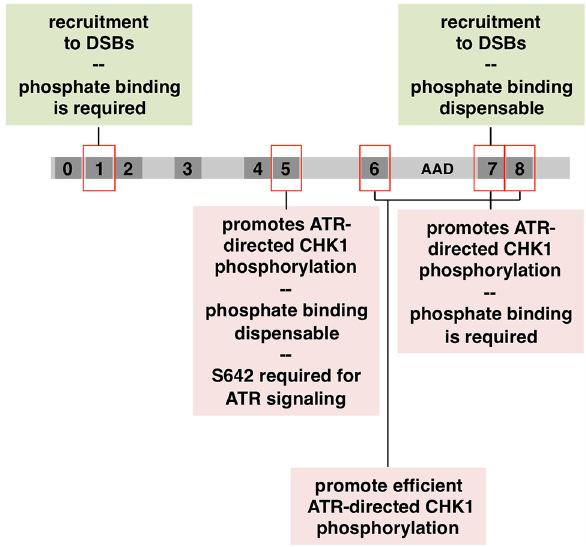
Figure 9. Summary of the TOPBP1 BRCT domains that participate in ATR signaling. Please see “Discussion” for